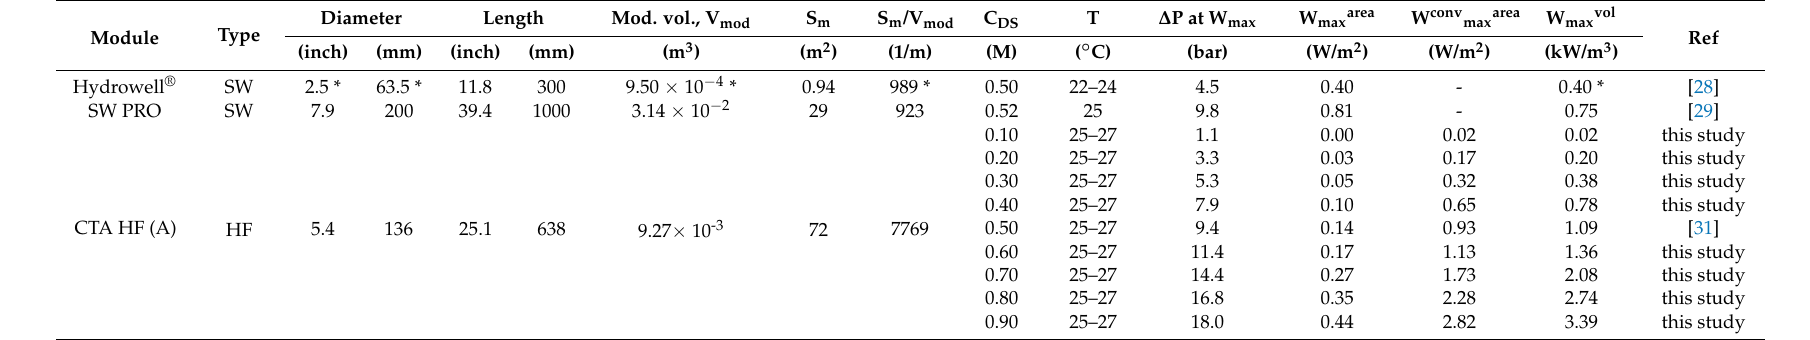
Table 2. Comparison of the PRO module performance with different